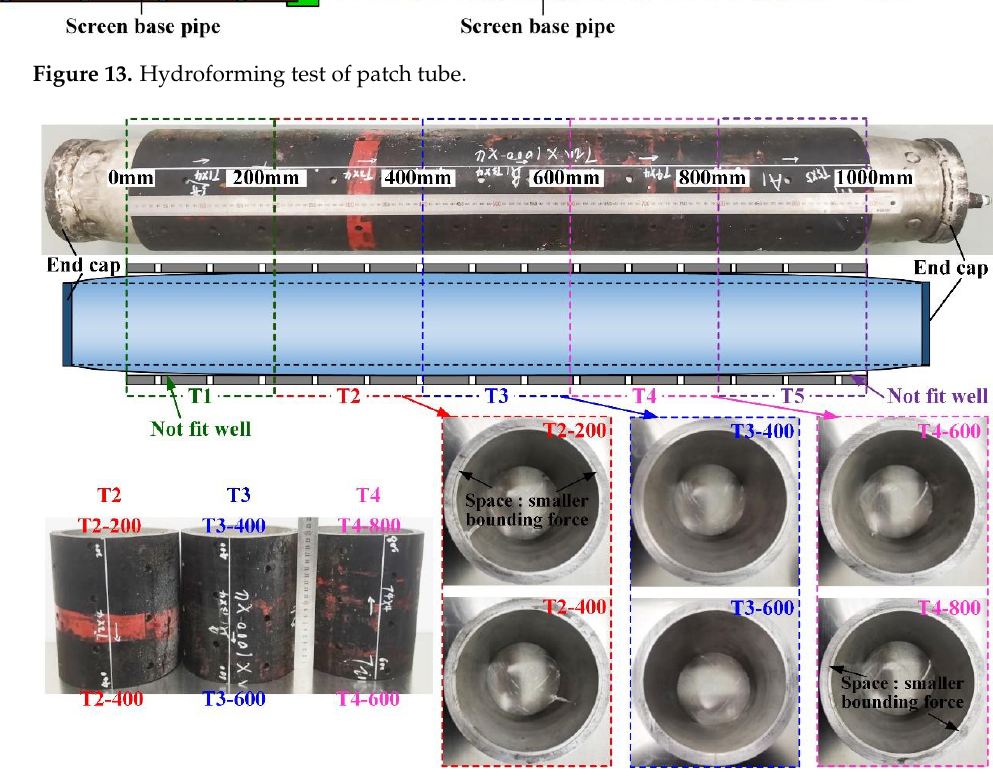
Figure 14. Hydroforming test results.